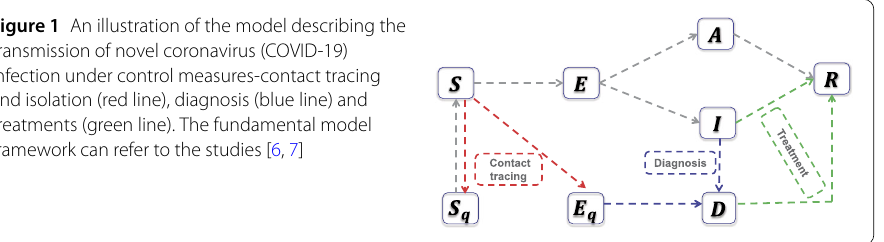
move to the exposed compartment E once effectively infected, or stay in the compart- ment S otherwise [6]. The transmission diagram is shown in Fig. 1 and the transmission dynamics model is given by